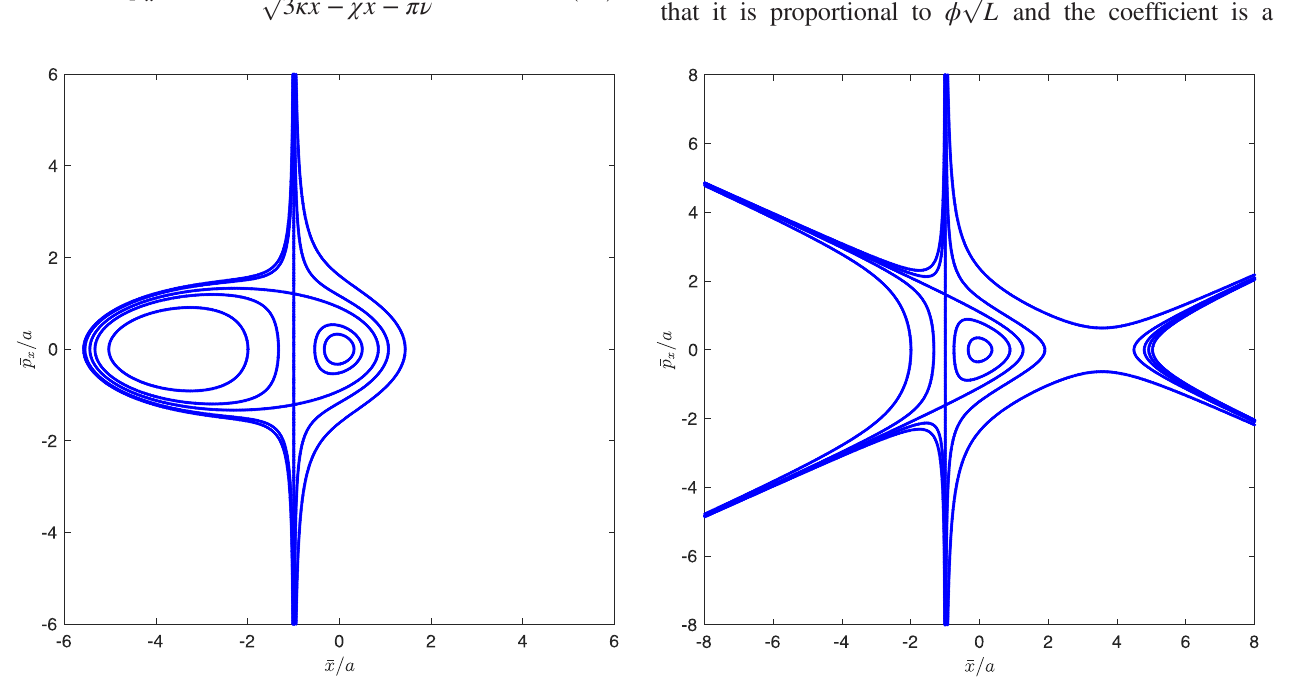
FIG. 6. Topology of the phase space for the effective Hamiltonian in Eq. (37) at the betatron tunes: ν ¼ 0 . 194 (left) and ν ¼ 0 . 28